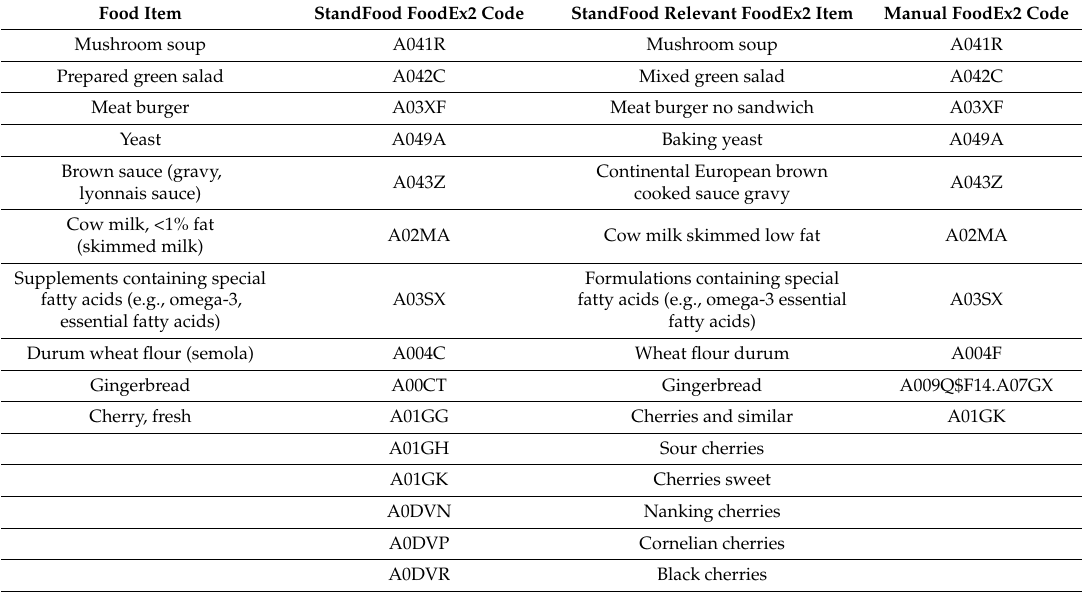
Table 4. Results from the StandFood description part for ten randomly selected instances. Food item represents the name of the food item in the test set. StandFood relevant FoodEx2 item is the name of the most relevant match that exists in the FoodEx2 found by the StandFood. StandFood FoodEx2 code is the FoodEx2 code of the most relevant match found by the StandFood. Manual FoodEx2 code is the FoodEx2 code that was manually assigned to that food item by a human